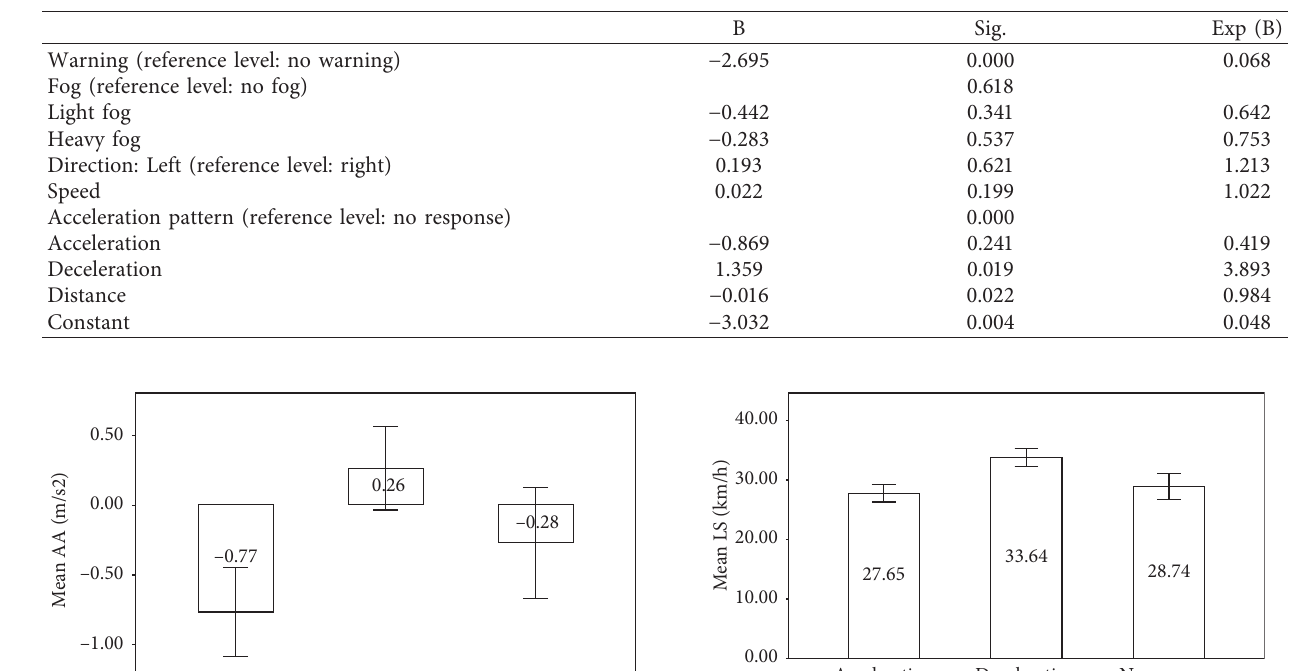
Table 6: Binary logit model results for CON.